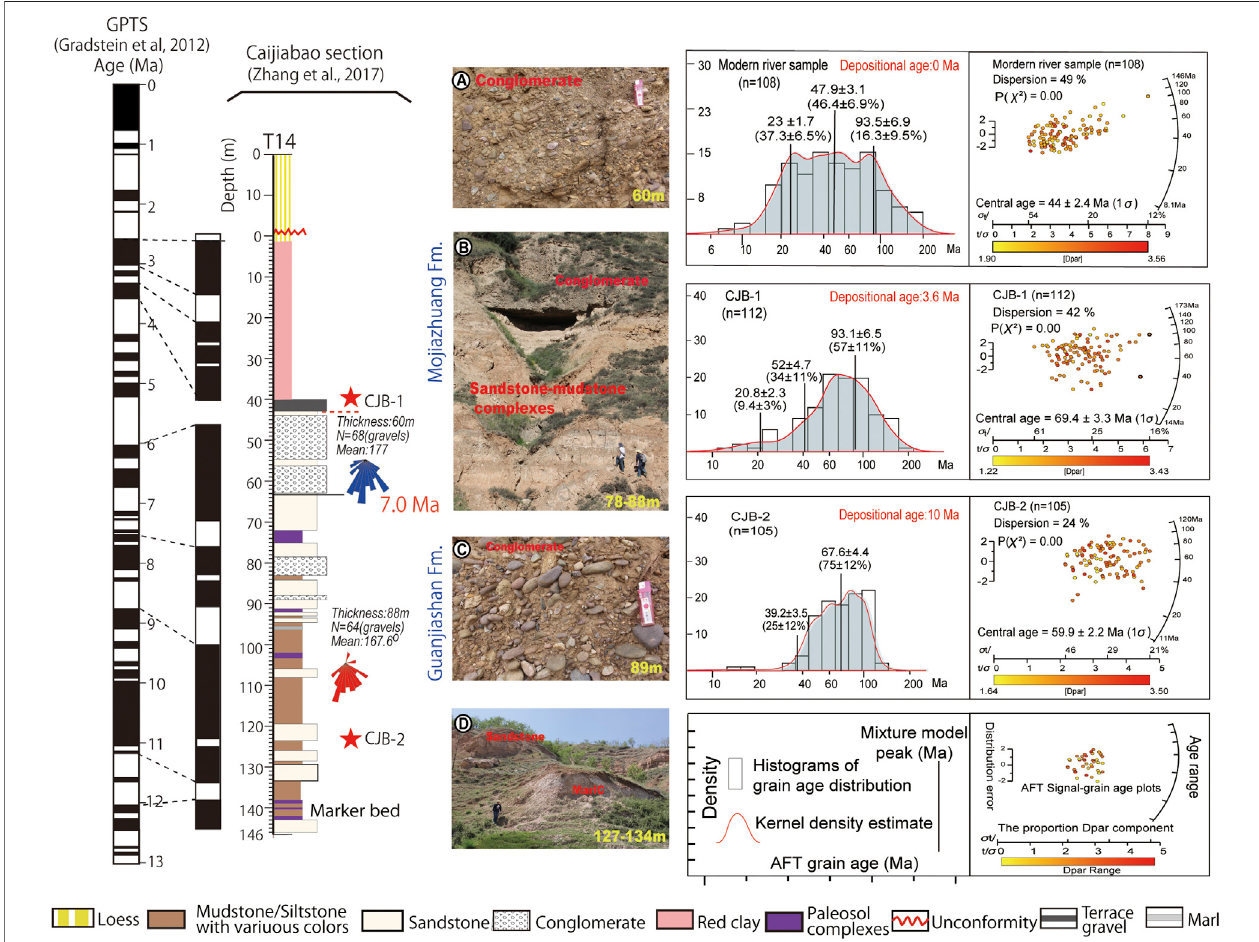
FIGURE 2 | Magnetostratigraphy, stratigraphic column, paleocurrent directions (from Zhang et al., 2017 except the new data marked by red arrows), sampling sites, and low-temperature thermochronology results for the Caojiabao (CJB) section. (A – D) Photographs showing the representative stratigraphy for the section. The detrital AFT grain ages of CJB-1, CJB-2, and modern river samples were statistically decomposed into components (with modeled component peak ages and proportions) and chi-square tests through RadialPlotter and DensityPlotter (Vermeesch, 2012).